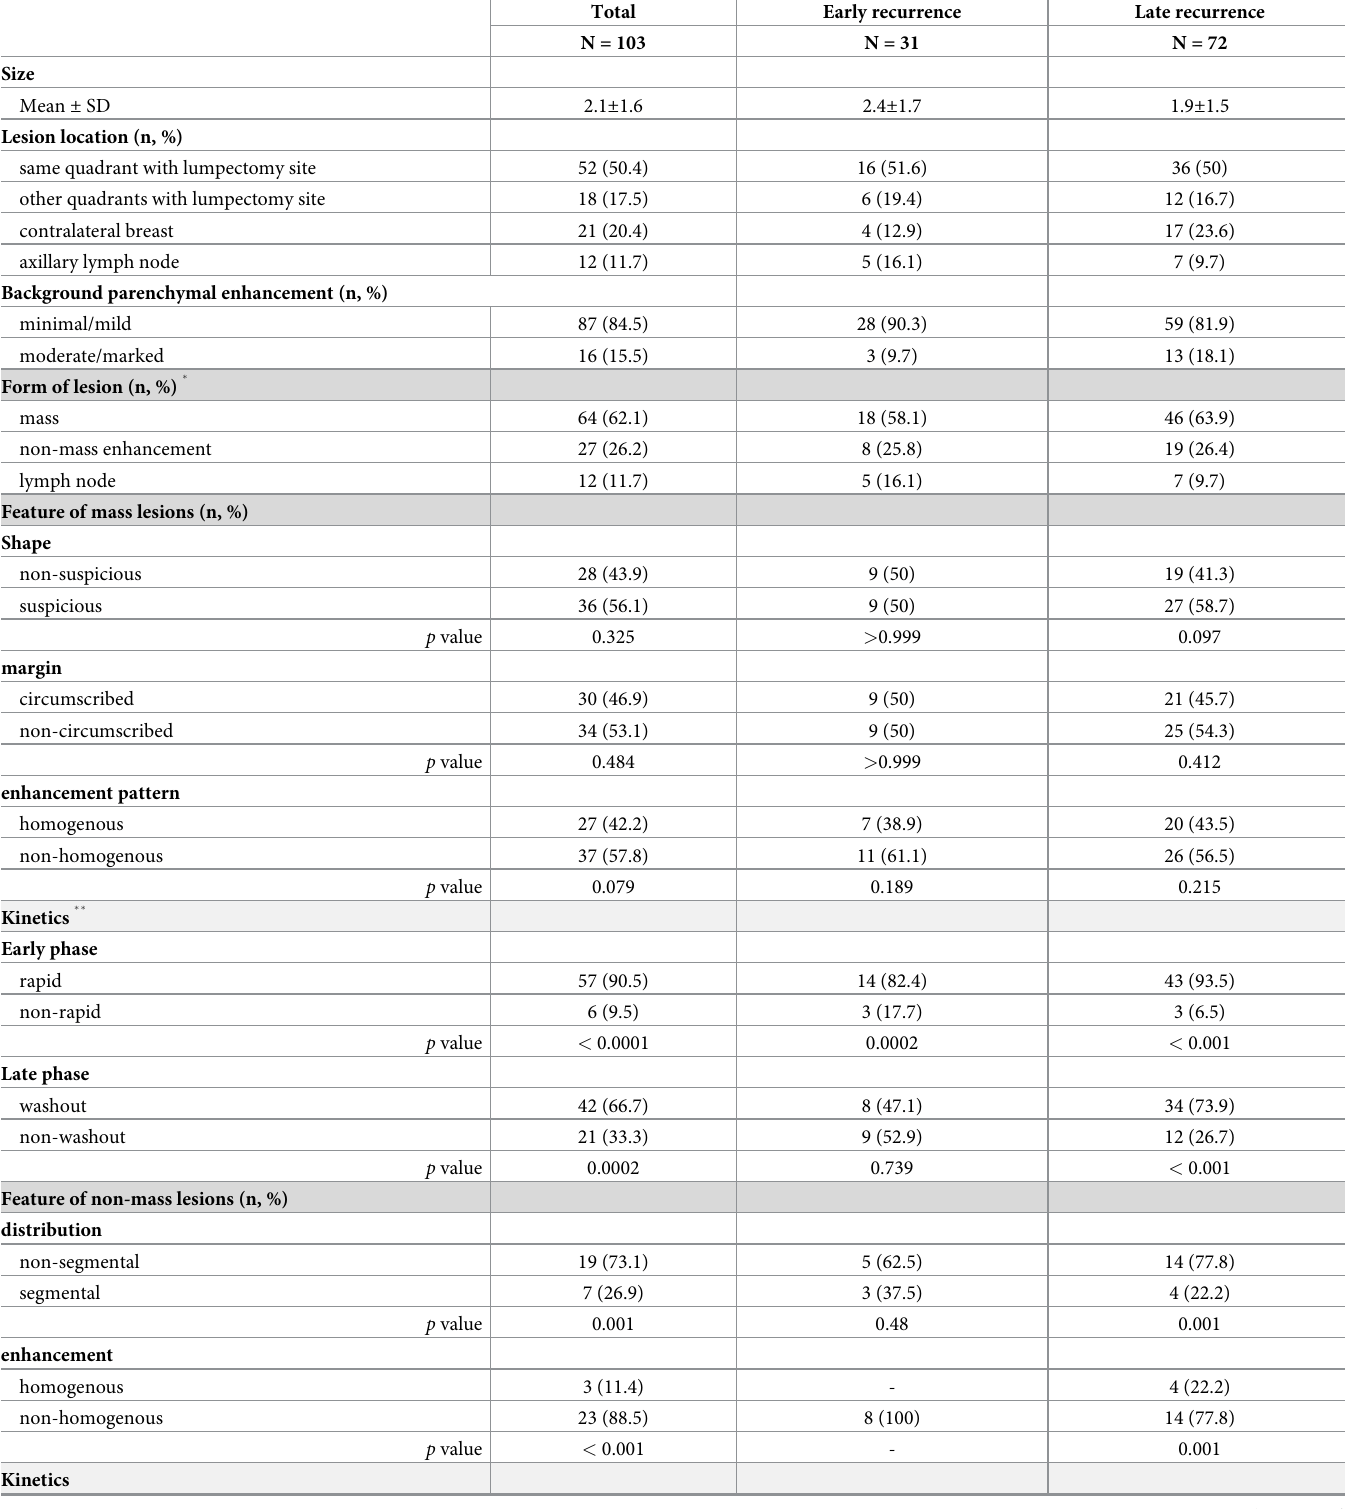
Table 4. MR characteristics of early and late recurrent